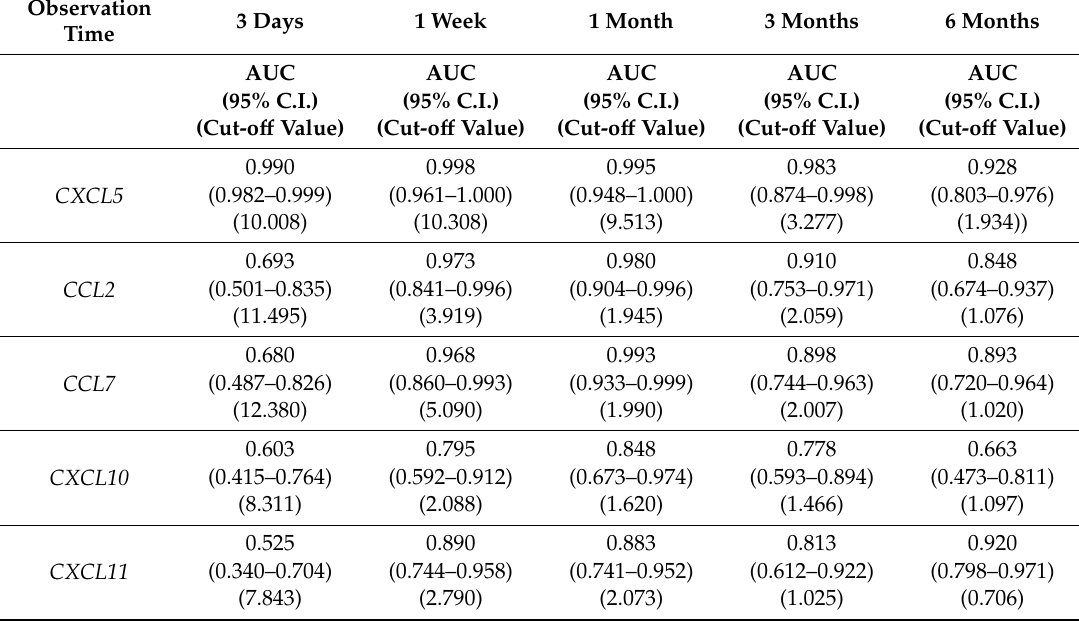
Table 3. Receiver operating characteristic (ROC) analysis between gene expression and pulmonary toxicity of nanomaterials.